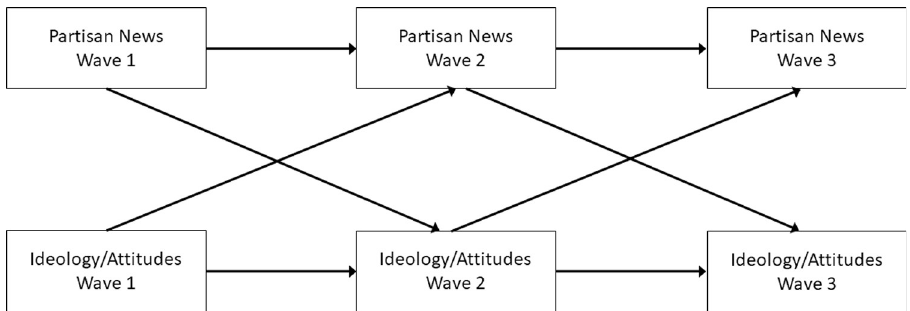
Fig 1. Conceptual figure showing auto-regressive and cross-lagged relations between news consumption, political ideology, and attitudes (longitudinal study). Correlations between variables (residuals for W2 and W3) within waves were modelled but not shown here for